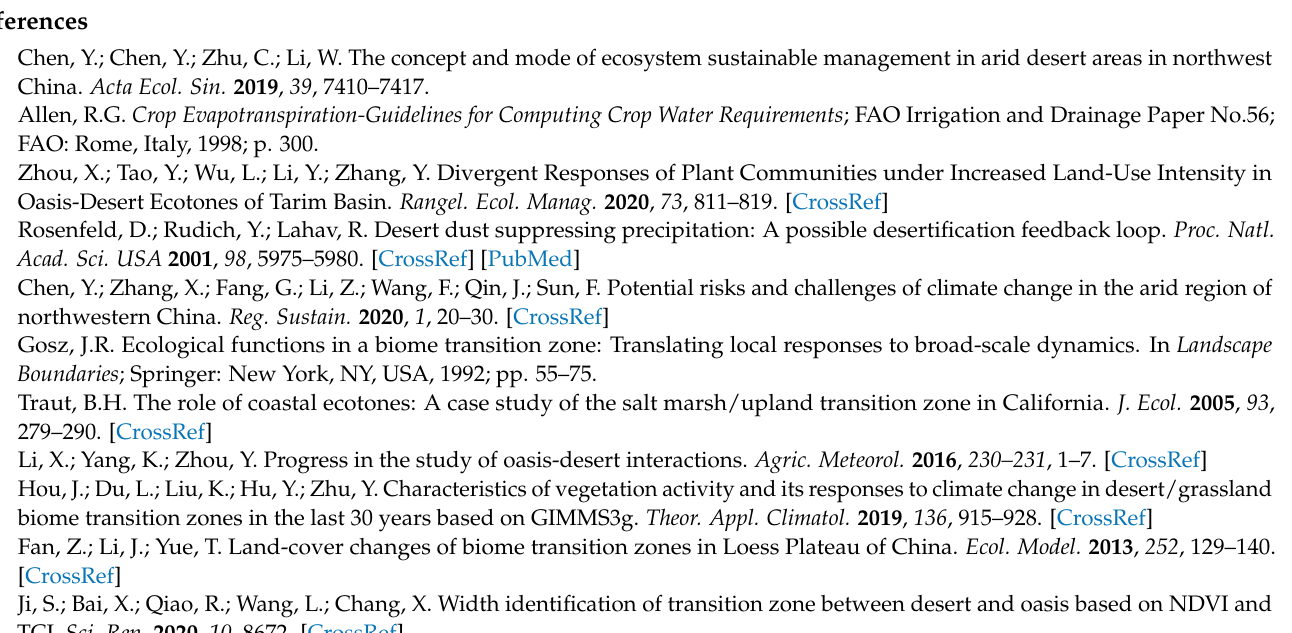
Land cover classification system; Table S3: SPEI categories; Table S4: Kappa index and consistency relationship; Table S5: Changes in the ecotone area of each basin in 1990, 2000, and 2015; Table S6: Transfer matrix of land-use area between 1990 and 2015 in the Tarim River Basin; and Table S7: